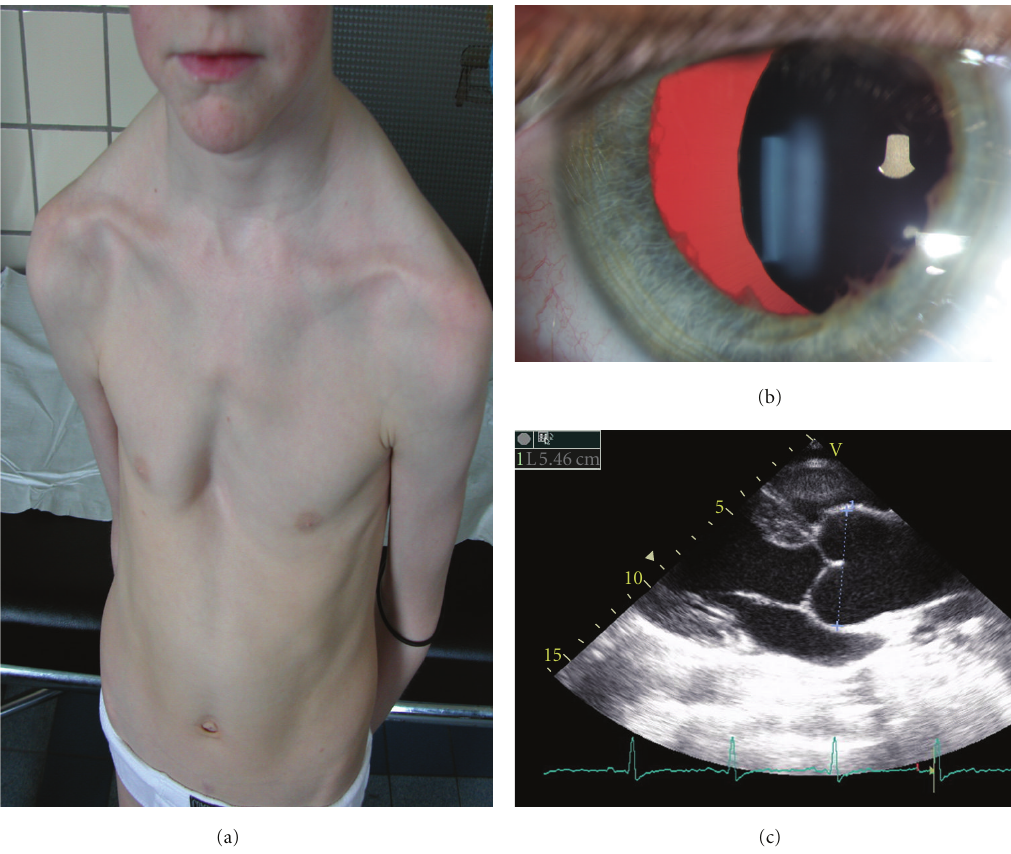
Figure 5: The Marfan syndrome. Patients present with skeletal findings such as pectus excavatum (a), lens luxation (b) and aortic root dilatation